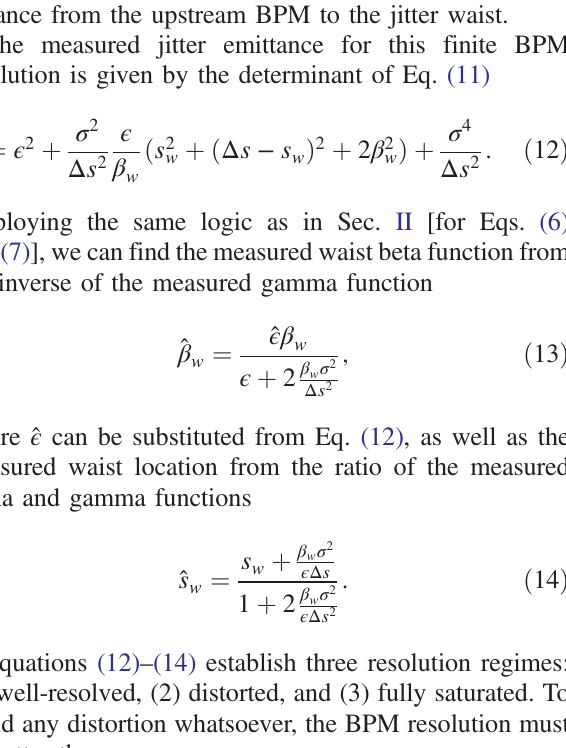
FIG. 3. Simulated two-BPM measurements over a large range of finite BPM resolutions. The BPMs are spaced 1 m apart and the jitter is focused 0.3 m from the upstream BPM with a 10 mm beta function and 0.1 mm mrad normalized